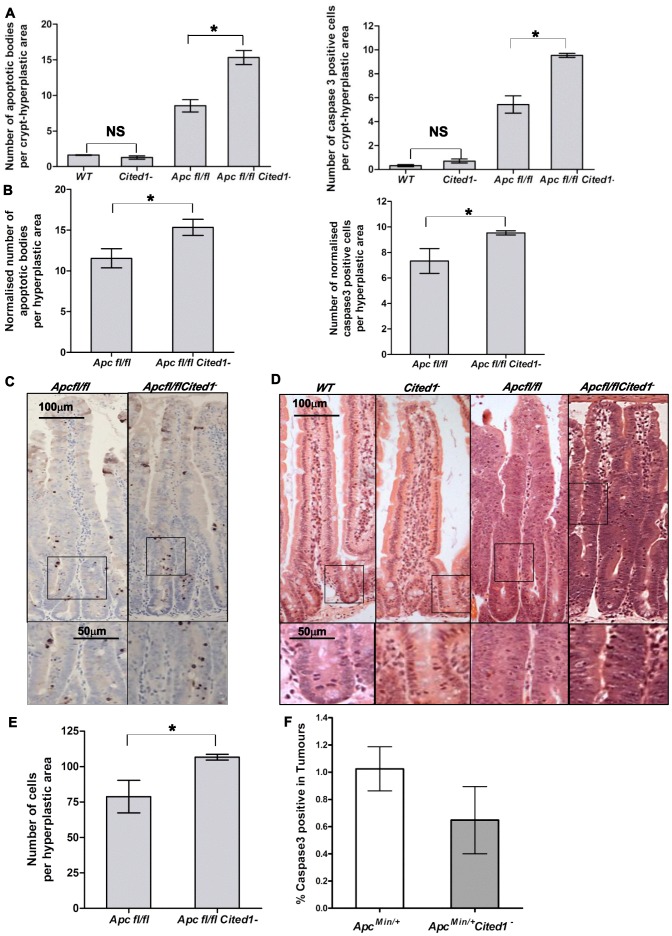

Cited1 deficiency enhances increased apoptosis in AhCre+Apcfl/fl mice.
A:
 Histograms showing the levels of apoptosis in each genotype. Apoptotic cells were scored by H&E staining (left) or cleaved-Caspase3 antibody (right). Both graphs show an increase in the number of apoptotic cells in AhCre+Apcfl/flCited1− compared to AhCre+Apcfl/fl (AhCre+Apcfl/fl<AhCre+Apcfl/flCited1−, Left: p = 0.0404; Right: p = 0.0259). No significant difference is observed between AhCre+WT and AhCre+Cited1− (AhCre+WT = AhCre+Cited1−, Left: p = 0.1914; right: p = 0.0952). B: The number of apoptotic cells were normalised to the number of total cells per hyperplastic area in AhCre+Apcfl/fl versus AhCre+Apcfl/flCited1−. After normalisation, the number of apoptotic cells is greater in AhCre+Apcfl/flCited1− compared to AhCre+Apcfl/fl (H&E: AhCre+Apcfl/fl<AhCre+Apcfl/flCited1−, p = 0.0404; cleaved-Caspase3: AhCre+Apcfl/fl<AhCre+Apcfl/flCited1−, p = 0.0259). C: cleaved-Caspase3 representative pictures showing an increase in apoptotic bodies in AhCre+Apcfl/flCited1− compared to AhCre+Apcfl/fl. D: Histology by H&E stained mouse intestinal sections in each genotype. Bottom panels show magnifications of intestine of corresponding zone. E: Scoring of epithelial cells per hyperplastic areas using the extent of BrdU labelling. Histograms show a significant increase in epithelial cell number in the hyperplastic areas from AhCre+Apcfl/flCited1− compared to AhCre+Apcfl/fl mice (p<0.05). *p<0.05; All statistical tests were done using Mann-Whitney U test ; NS Non significant. (n = 3/genotype). F: Histograms showing the levels of apoptosis (cleaved Caspase 3 antibody) in tumours of ApcMin/+ (white) and ApcMin/+Cited1− mice (Grey). There is no significant difference between the 2 genotypes (p>0.05, Mann-Whitney U test).